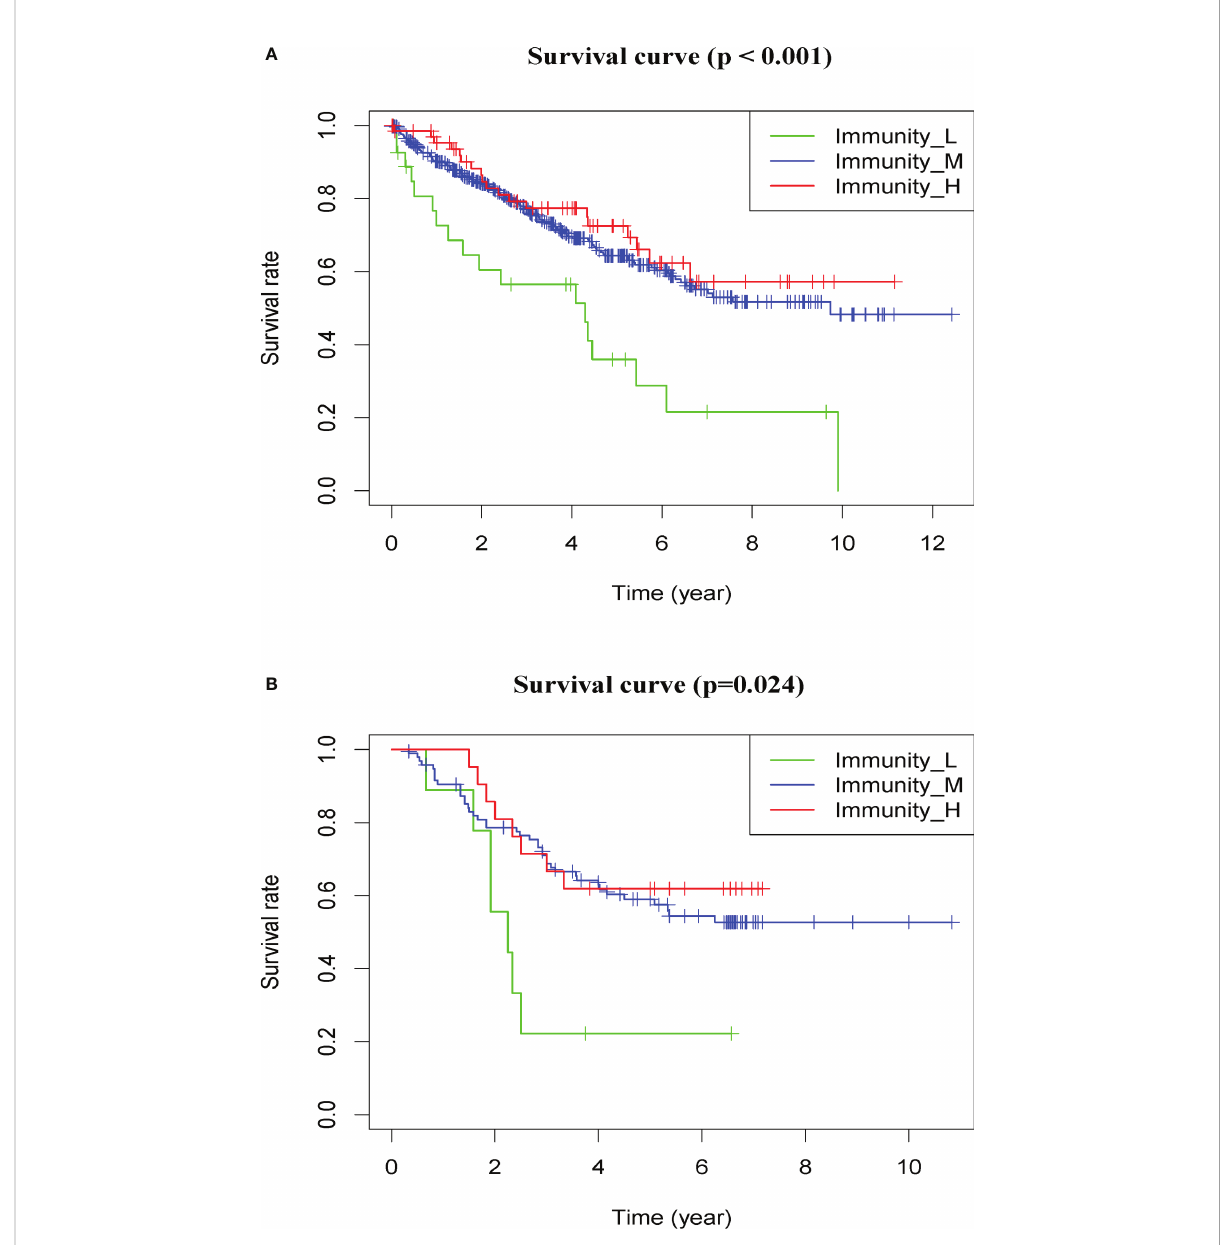
FIGURE 4 Prognostic value of the immunotype in patients with ccRCC in the discovery set and validation set. Kaplan – Meier survival analysis of overall survival in patients in different groups in the discovery set (A) and validation set (B)